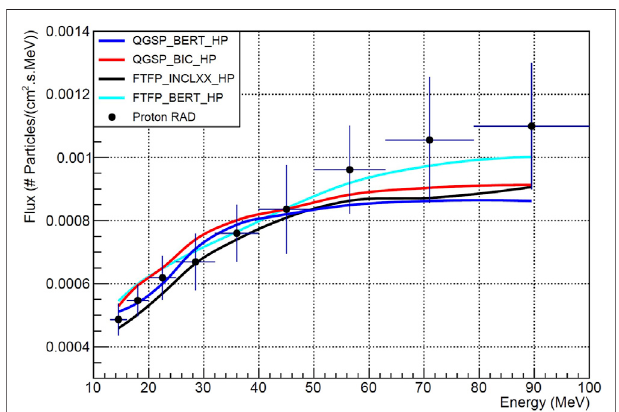
FIGURE 2 | Proton spectra reaching the Mars surface within the RAD fi eld-of-view due to GCR-protons, helium, carbon and oxygen nuclei described with the GCR ISO-15390 model, simulated with dMEREM using four different physics lists compared to RAD proton differential fl ux measurements of September